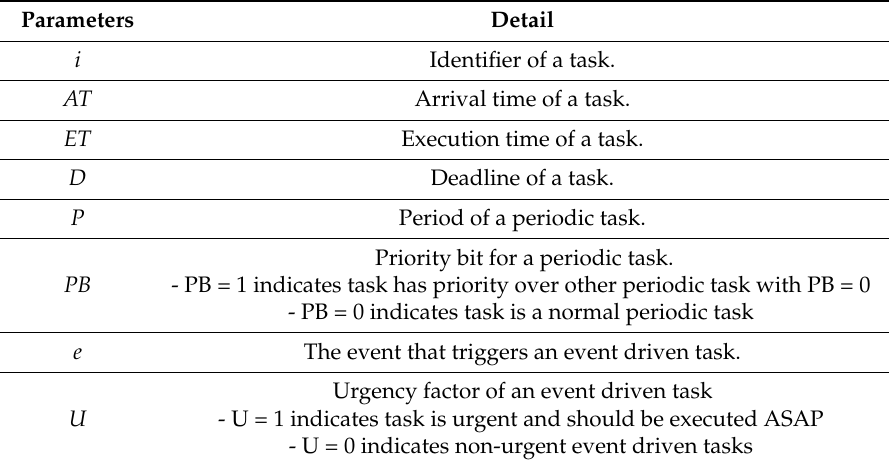
Table 1. Task set parameters for periodic and event driven